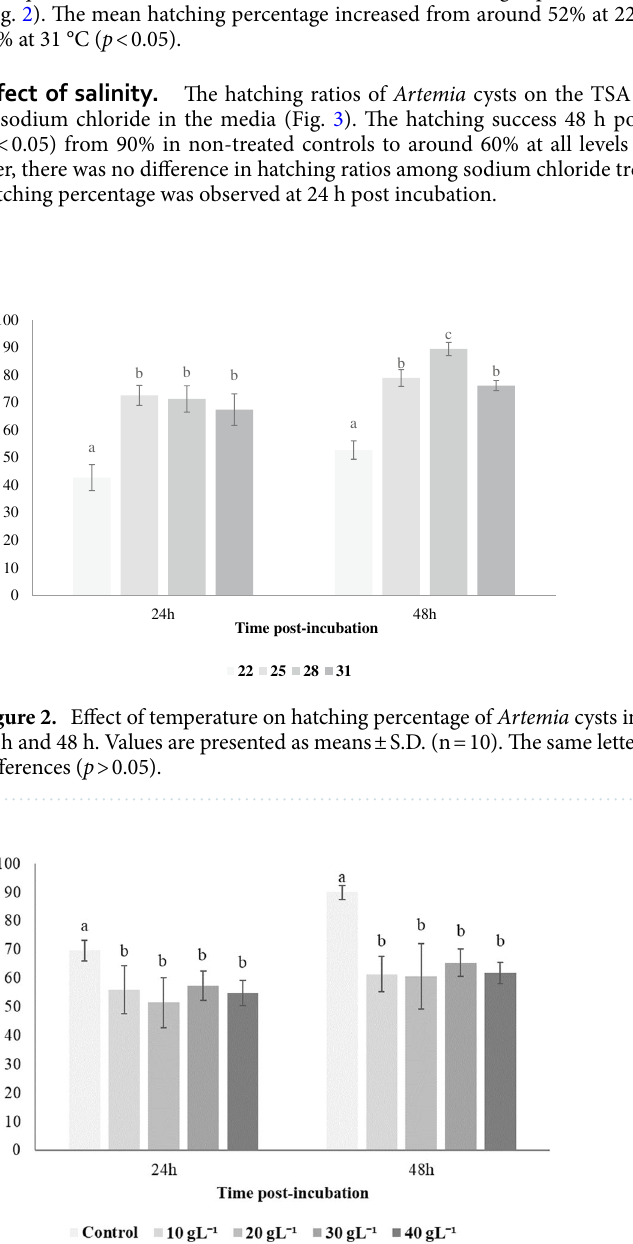
Figure 3. Effect of salinity on hatching percentage of Artemia cysts incubated on tryptic soy agar for 24 h and 48 h. Values are presented as means ± S.D. (n = 10). The same letters indicate statistically insignificant differences ( p >